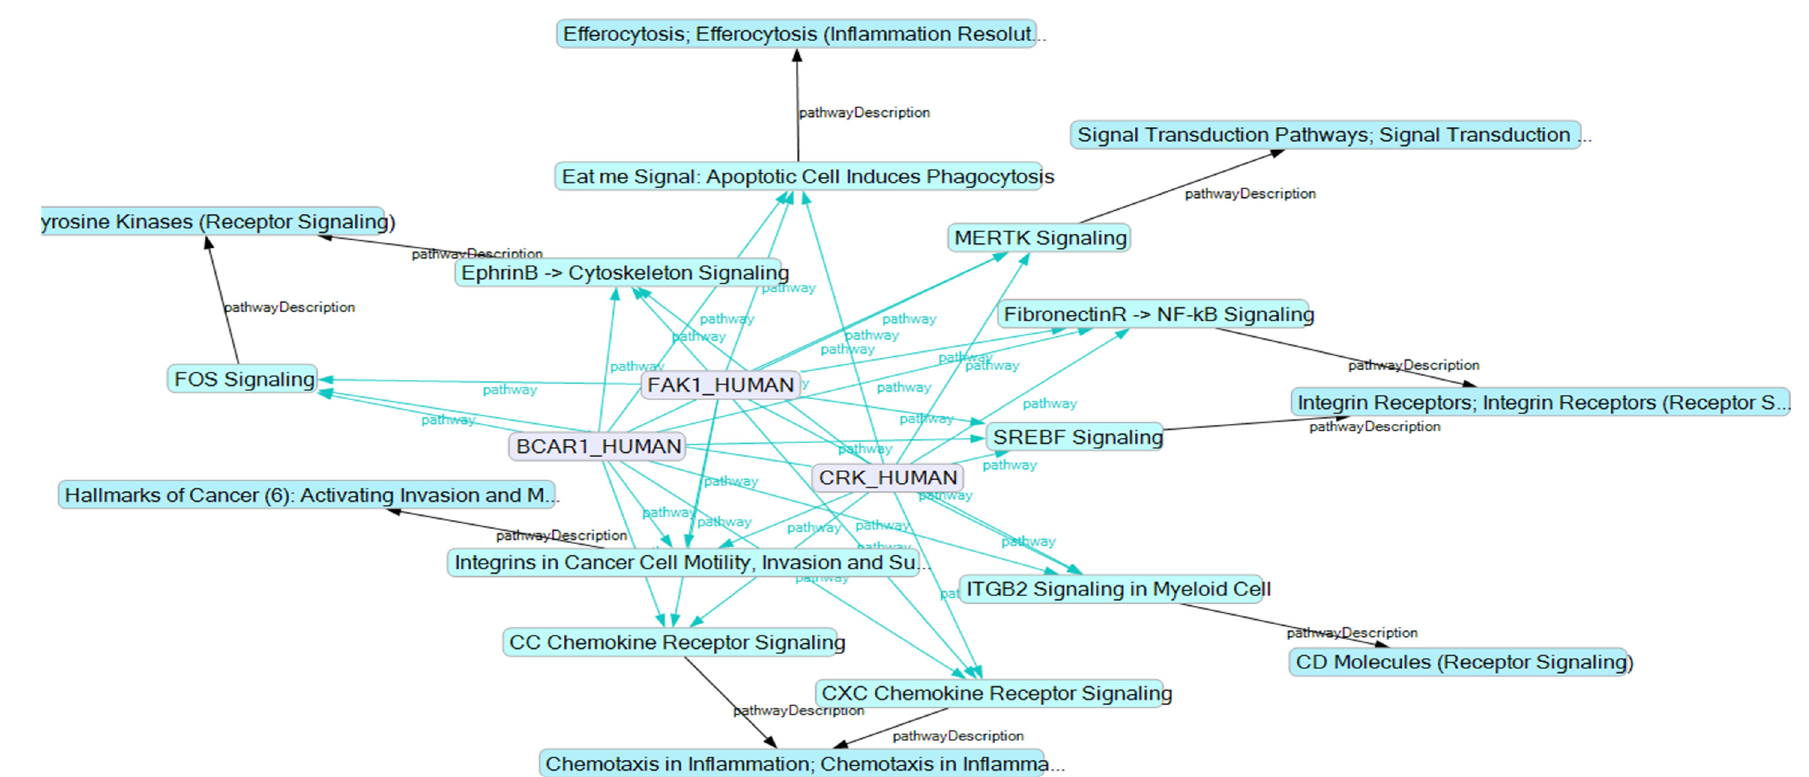
Figure 6. Signaling pathways, of which each includes BCAR1 and FAK1 (PTK2) and CRK. These pathways are included in Figure 5 but are shown here in more detail. The proteins are indicated by human entry names. The signaling pathways are named within light blue rectangles. They had been identified in Reactome assigned to their headings. Also see Supplementary Table S1.